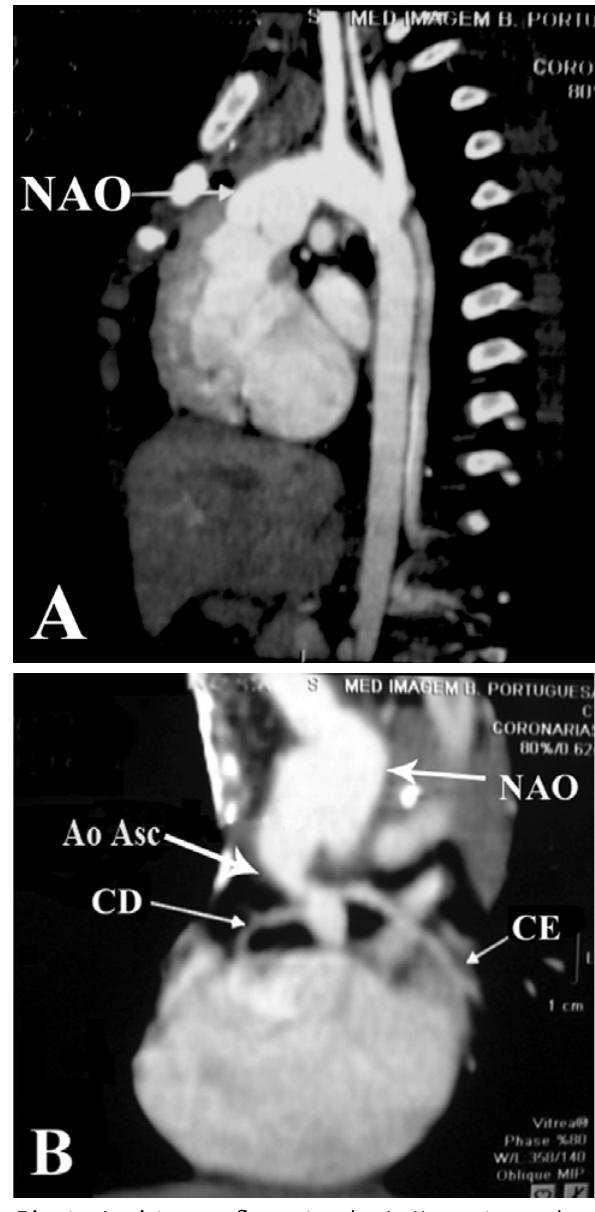
Fig. 4 - Angiotomografia mostrando: A: Neoaorta com bom resultado anatômico 2 anos após a cirurgia e B: Aspecto das artérias coronárias e da aorta nativa anastomosada à neoaorta. Legenda: NAO= neoaorta, CD= coronária direita, CE = coronária esquerda e AoAsc = aorta ascendente